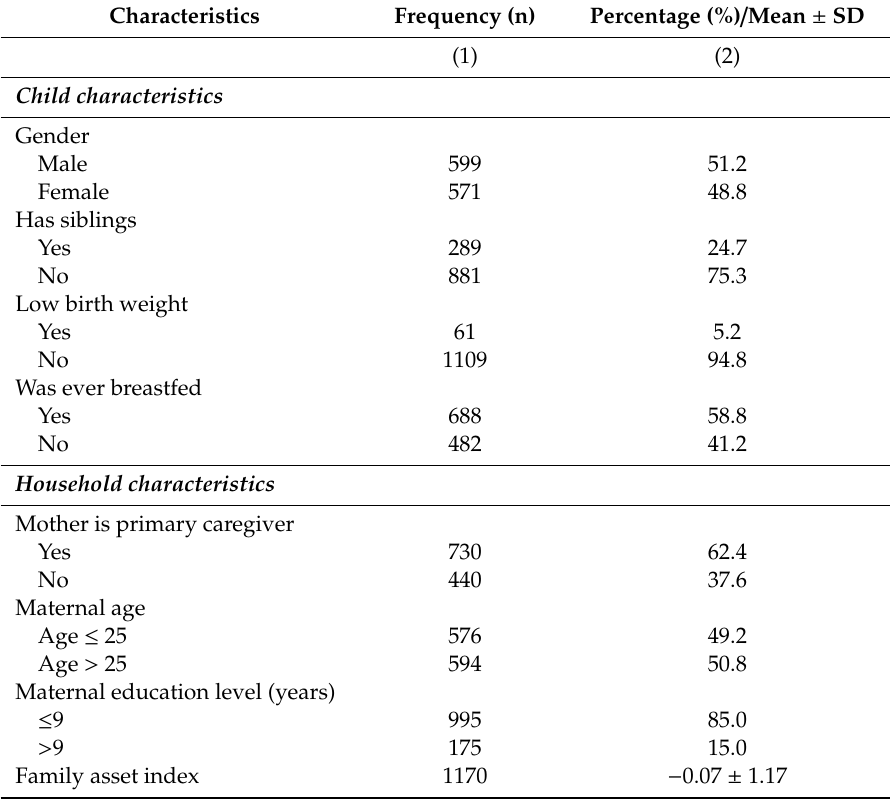
Table 1. Basic characteristics of sample children (6–12 months) (n =